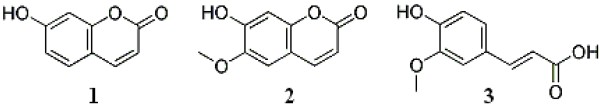
Chemical structures of compounds isolated from a Biebersteinia multifida root extract, including umbelliferone (1), scopoletin (2) and ferulic acid (3).